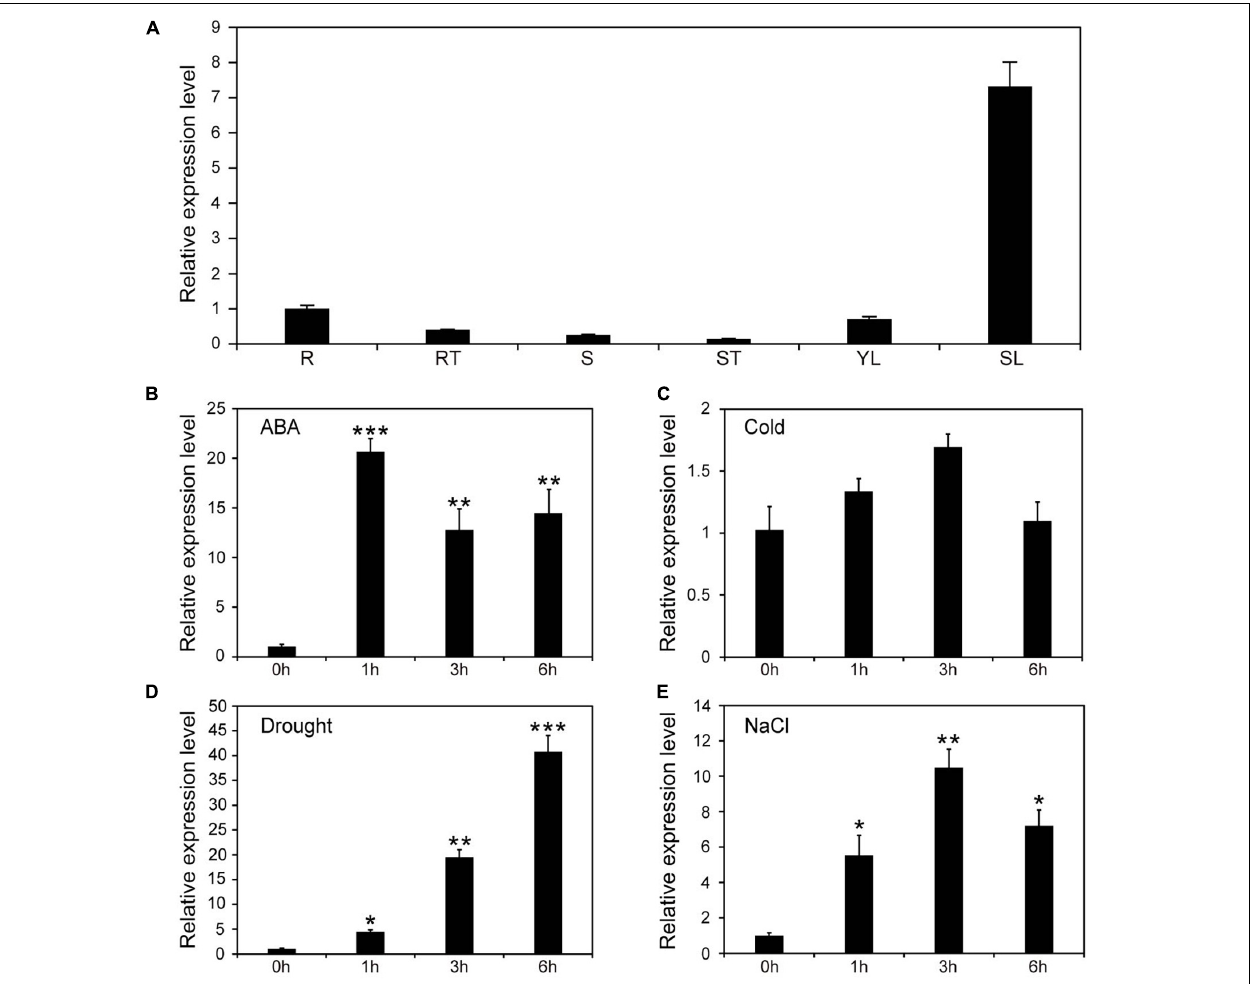
FIGURE 1 | Expression patterns of NtNAC053 in tobacco. (A) The expression pattern of NtNAC053 in tested tissues. R: root; RT: root tip; S: stem; ST: stem tip; YL: young leaf; SL: senescent leaf; Expression pattern of NtNAC053 under ABA (B) , cold (C) , drought (D) , and salt (E) treatments. The data were means ± SD from three independent replications. * p < 0.05, ** p < 0.01, *** p < 0.001 ( t